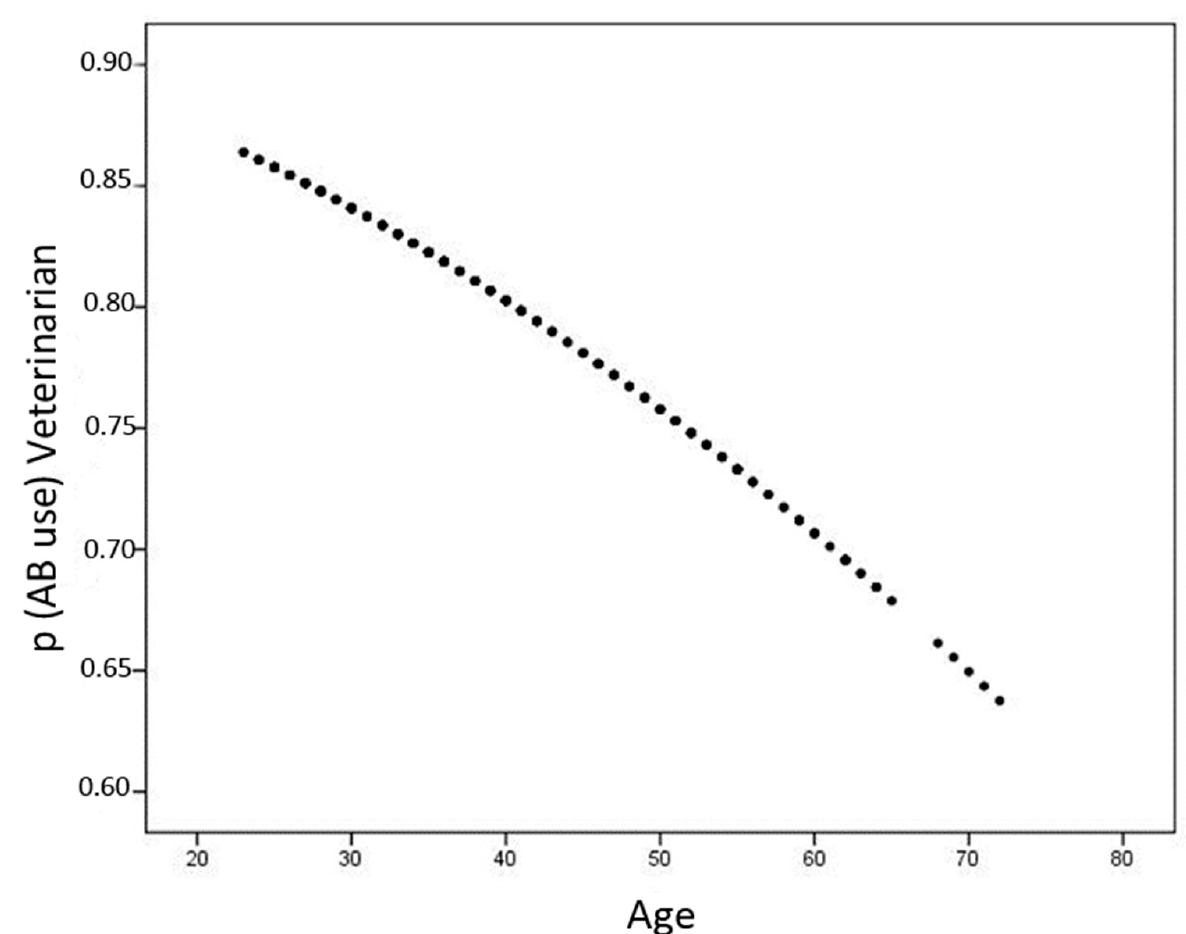
Figure 2. The probability of veterinarians using an antibiotic for the treatment of NCD depended on their age.